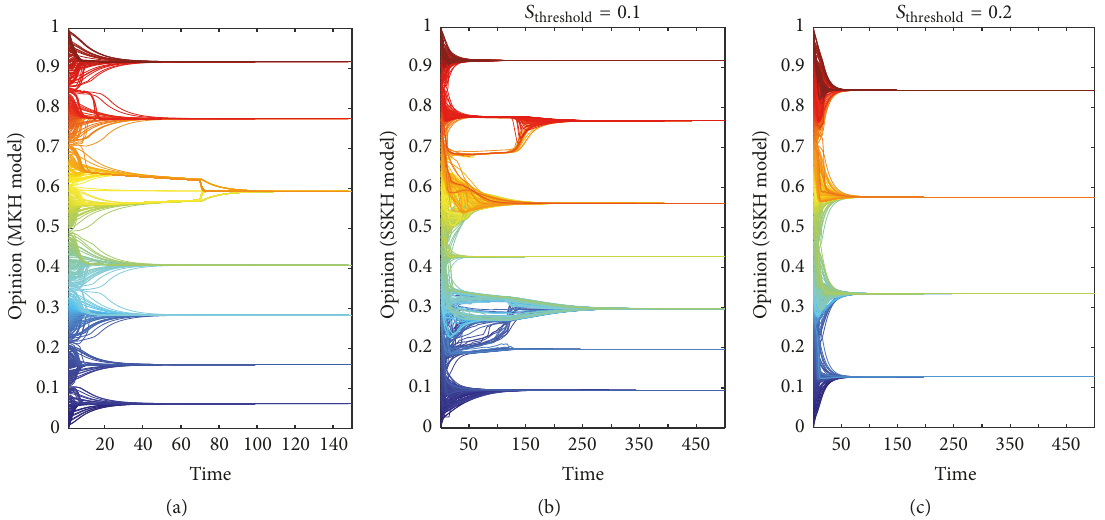
= 0.1, 0.2 ) when 𝜀 = 0.05 threshold